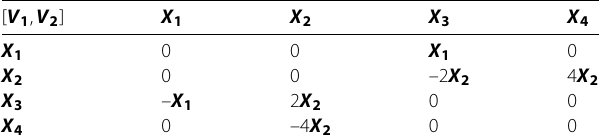
Table 2 Commutator table after optimization [ V 1 , V 2